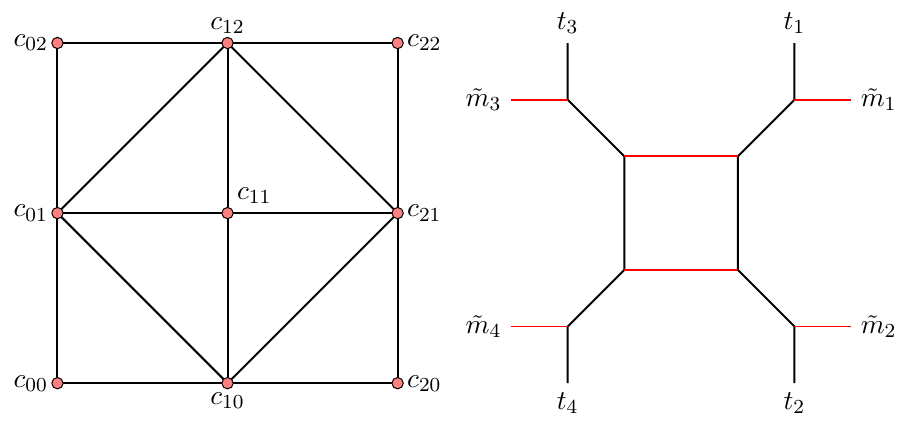
Figure 1. The toric diagram and its dual diagram for SU(2) with 4